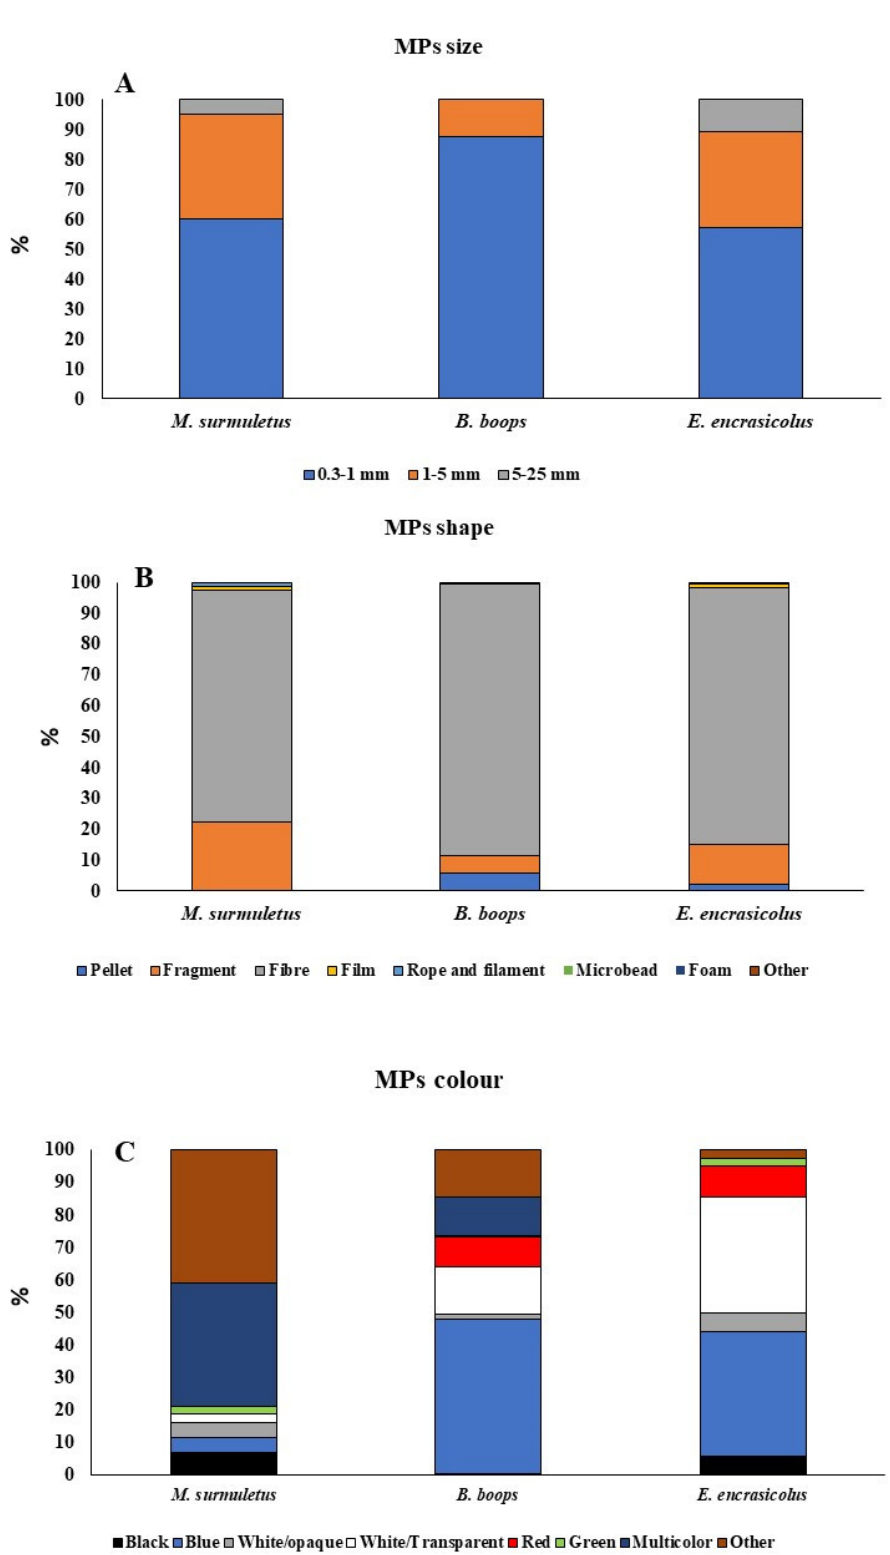
Figure 2. Relative abundance of different types of MPs ingested in commercial fish. ( A ) MPs size ( B ) MPs shape ( C ) MPs colour.